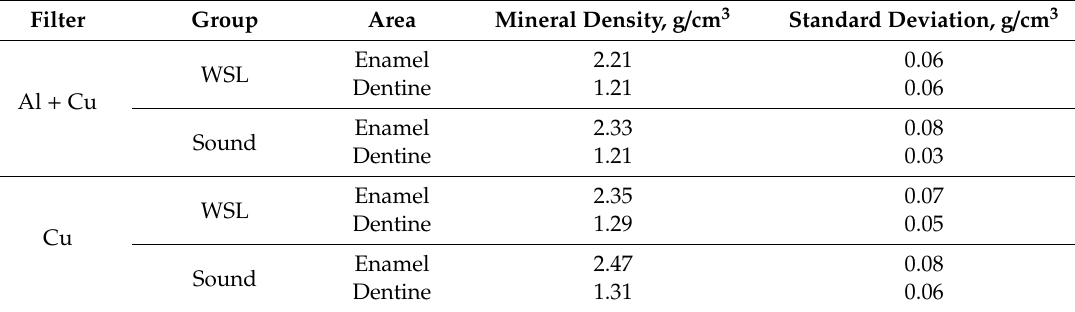
Table 1. Mineral density of the tooth